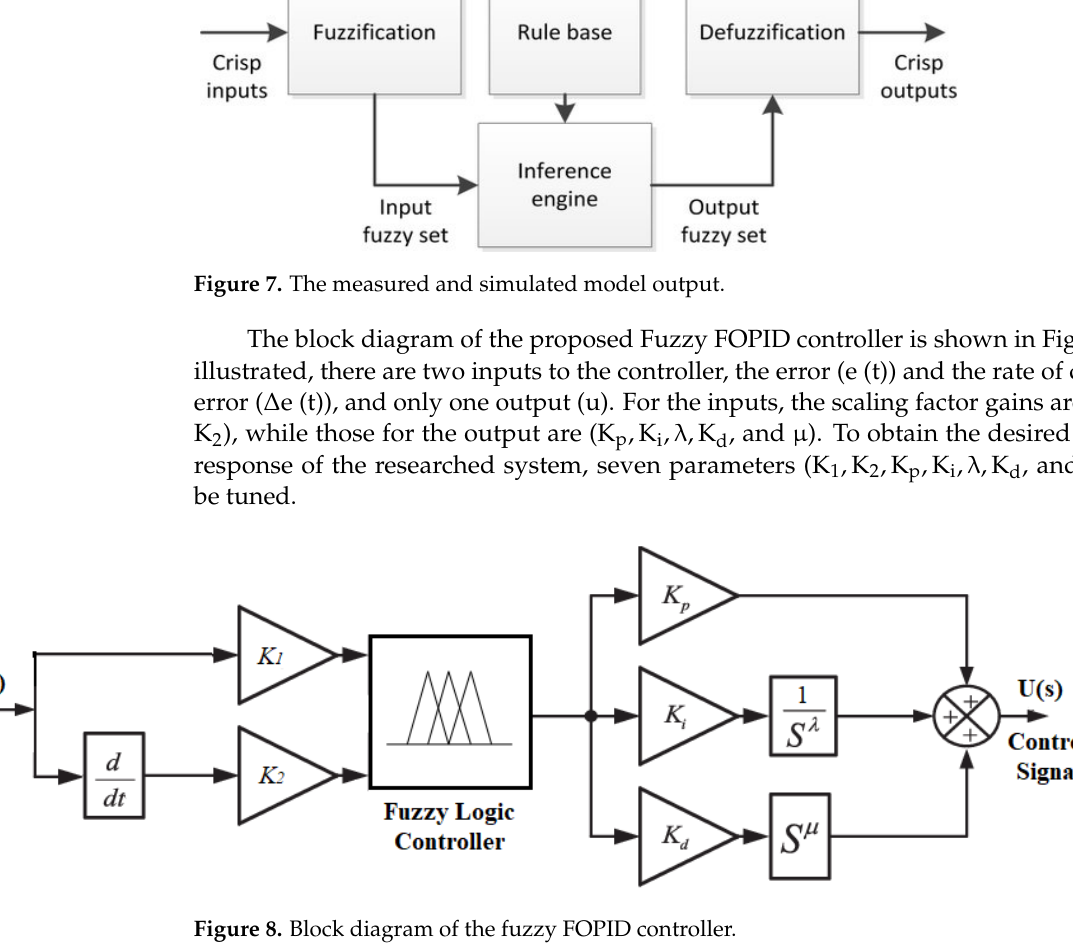
Figure 6. Model residual.